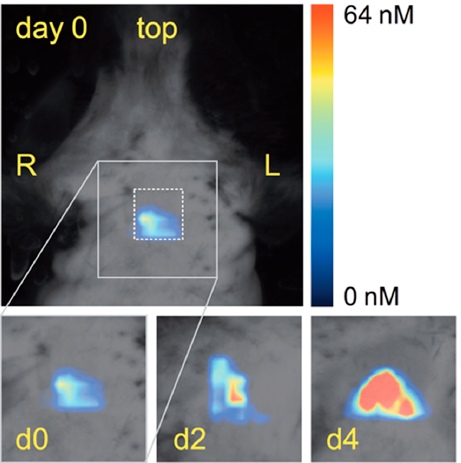
Figure 8. Fluorescence-mediated tomography (FMT) reliably quantifies 1,1 ′ -dioctadecyl-3,3,3 ′ ,3 ′ -tetramethylindotricarbocyanineiodide (DiR)-enhanced green fluorescent protein (eGFP) macrophage recruitment over time in a region of interest covering aortic sinus, aortic arch, and brachiocephalic artery of ApoE − / − mice. (Reprinted from Reference [261]. Copyright with permission from © 2013, Wolters Kluwer Health.)